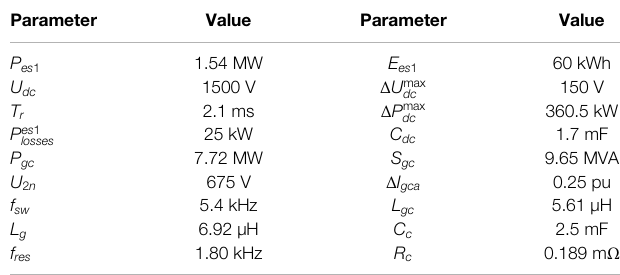
TABLE 2 | Summary of the ESS parameters obtained using the proposed